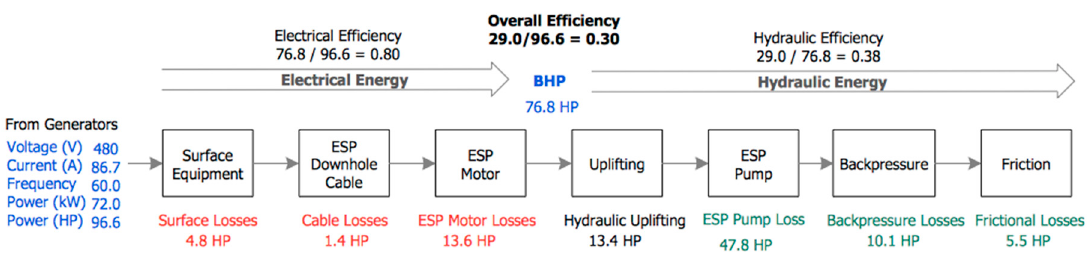
Figure 7. EROI-lifting and energy intensity for 18 ESP systems.